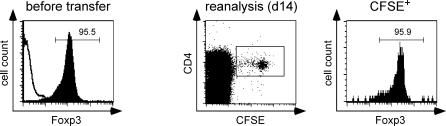
Stable Foxp3 Expression in CD25+CD4+ TregsCD25+CD4+ Tregs were isolated ex vivo from pooled spleen and LN single-cell suspensions, labeled with CFSE, and then transferred into syngenic 8-wk-old recipients (2 × 106/mouse). Before transfer, sorted cells were analyzed for intracellular Foxp3 expression by FACS. Fourteen days after transfer, splenocytes of recipient mice were stained for CD4, CD25, and Foxp3, and analyzed by FACS. About 0.1% of total splenocytes and, accordingly, 3% of total Foxp3+ splenocytes were donor derived (CFSE+). Representative dot and histogram plots from four independently analyzed mice were selected. Numbers display frequency of cells within indicated populations. Comparable results were obtained for cells isolated from peripheral or mesenteric LNs (unpublished data). The bars in the left and right graphs indicate the marker gate for Foxp3+ cells. The box in the middle graph indicates the region that was used to gate for CD4+CFSE+ cells. These gated cells (CFSE+) are depicted in the right graph.